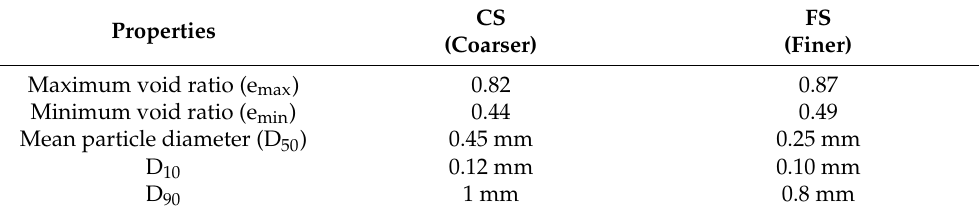
Table 1. Basic soil properties.